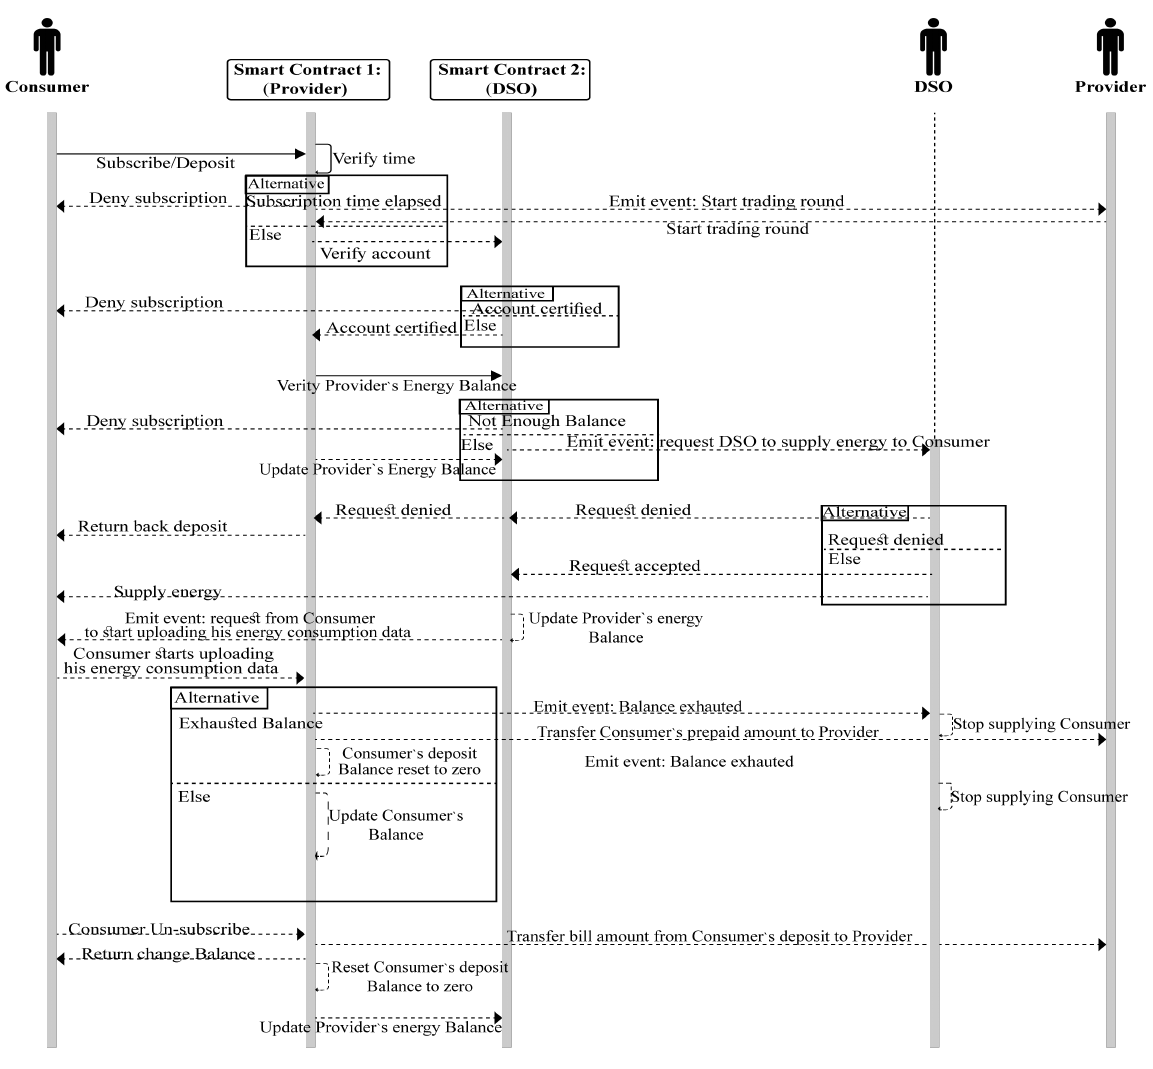
Figure 9. The proposed P2P Energy trading sequence